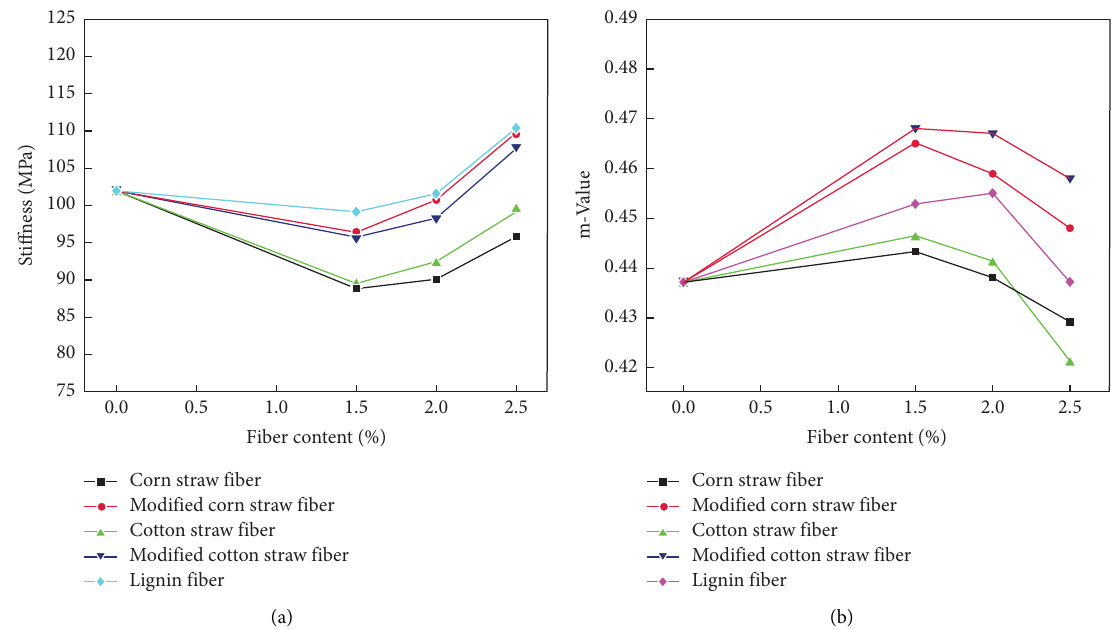
Figure 9: Efects of fber type and content on stifness and m -value of asphalt binder at − 12 ° C. (a) Stifness. (b) m -value.